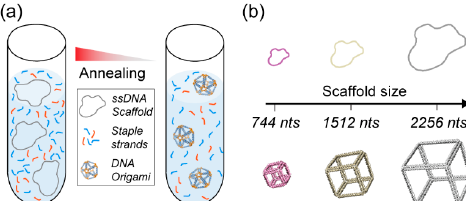
Figure 1. DNA origami nanoparticle assembly. ( a ) DNA origami are folded with a long single-stranded DNA scaffold and multiple staple strands via a thermal annealing process. ( b ) Controlling the DNA origami size with custom scaffold lengths.